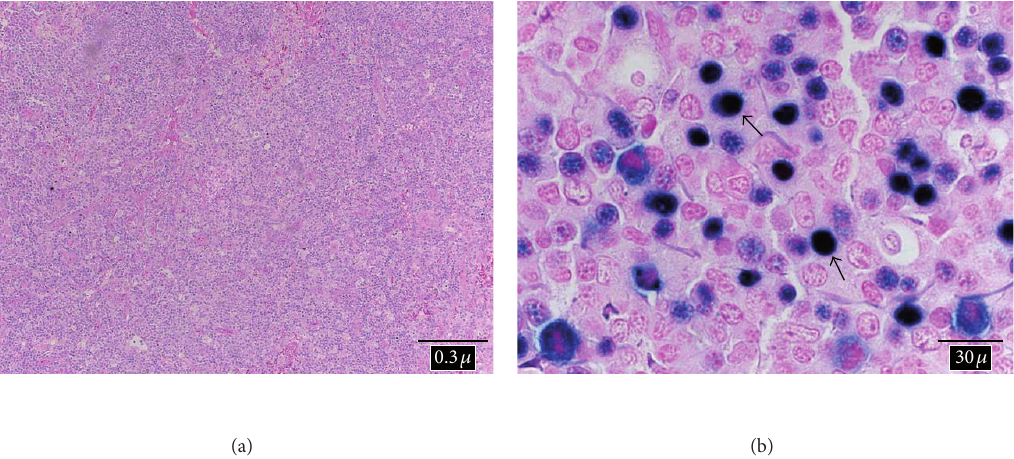
Figure 2: Lymph node biopsy: (a) low power view of H&E-stained section of lymph node biopsy showing diffuse effacement of the normal lymph nodearchitecture by a mixed infiltratecomprised of smalllymphocytes, plasma cells, histiocytes,and scattered largecells with vesicular chromatin, irregular nuclear contours, and conspicuous nucleoli (10x magnification). Relatively frequent mitoses were also observed scattered throughout the specimen. (b) EBV in situ hybridization analysis for the detection of EBV-encoded RNA (EBER) reveals abundant positive cells with dark nuclear staining, consistent with EBV infection. Arrows point to large atypical EBV-positive cells (100x